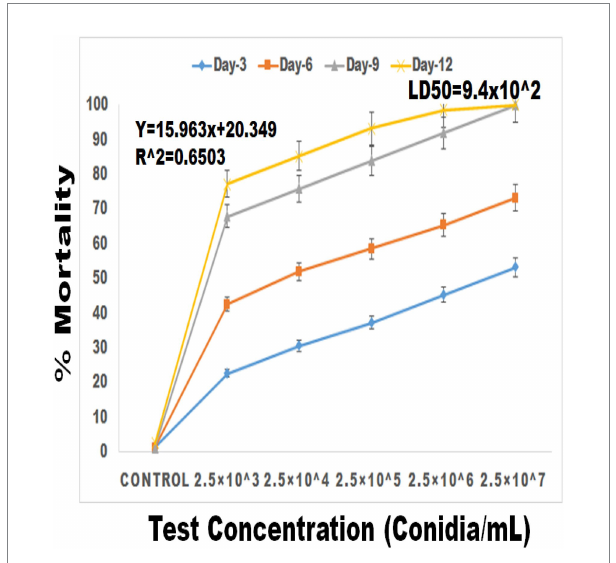
FIGURE 6 Percentage mortality of S. frugiperda after treatment of M. majus conidia for 3, 6, 9, and 12 days under laboratory condition. A M. majus conidia treatment at 3, 6, 9, and 12 days of